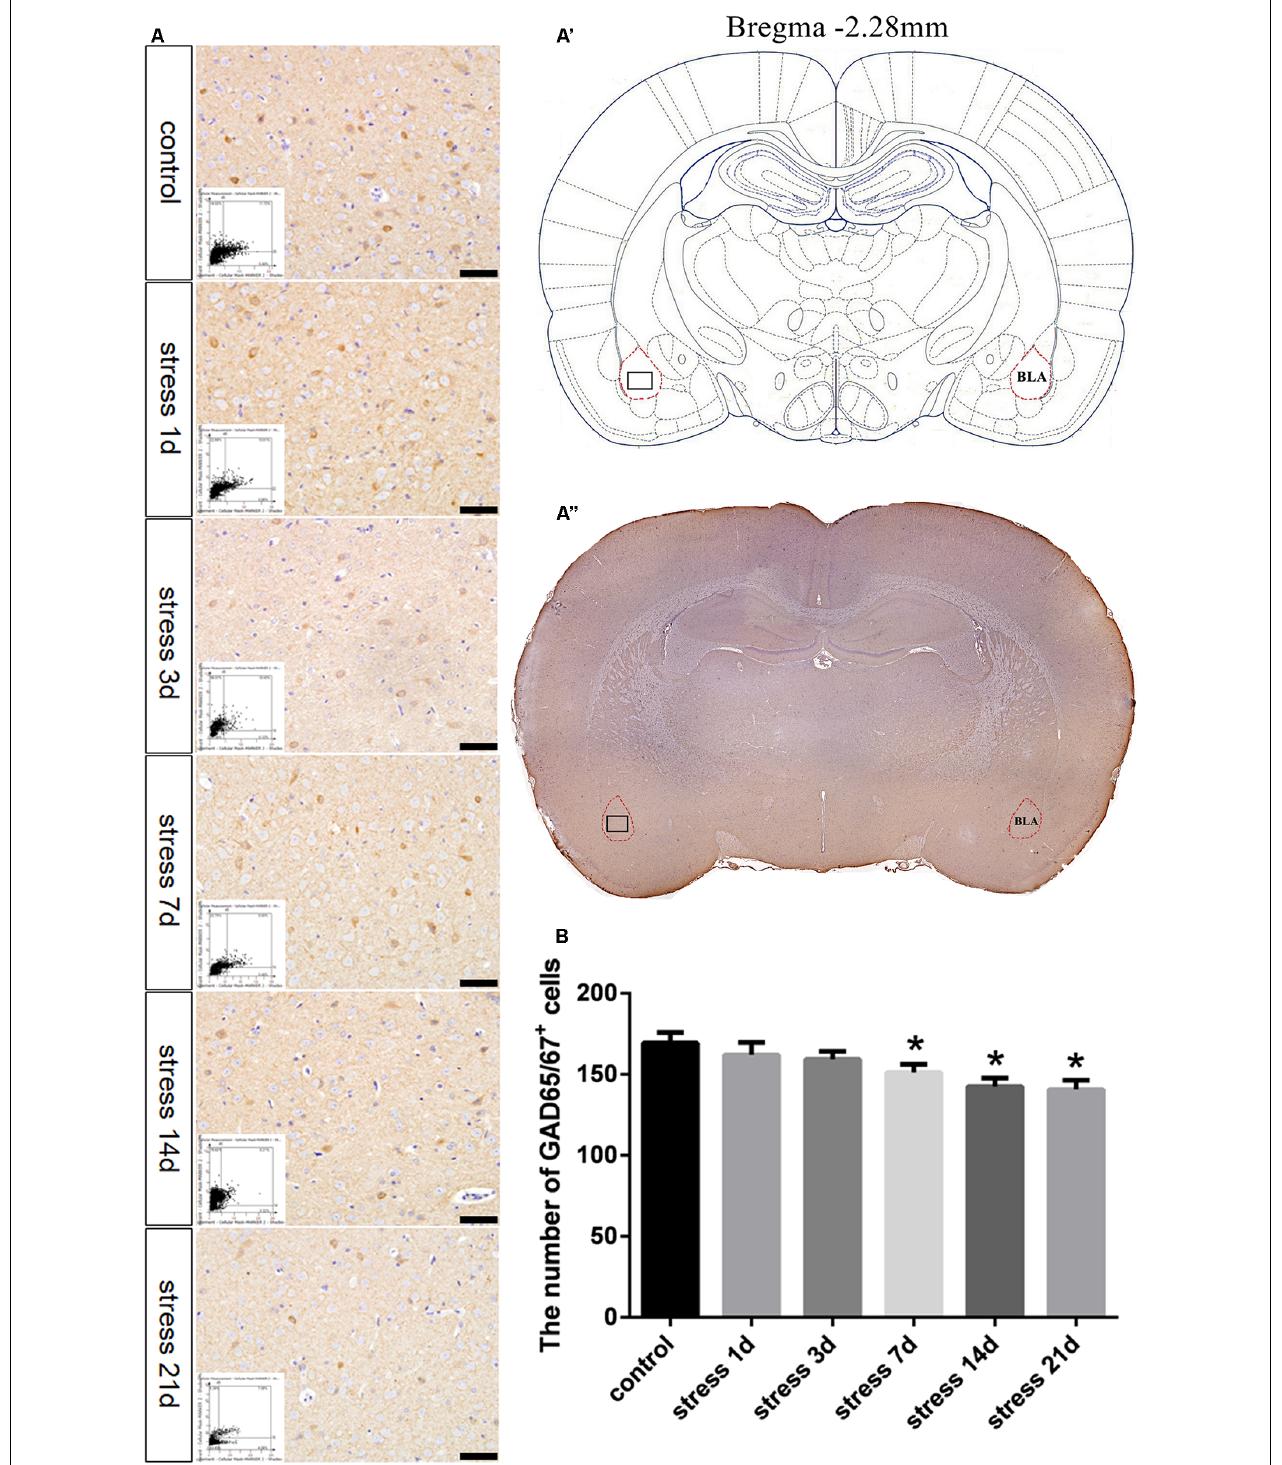
FIGURE 3 | Stress contributed to decrease in the number of GABAergic neurons. (A) Representative images showing GAD65/67 immunohistochemistry in the BLA. Images obtained by microscopy-based multicolor tissue cytometry (MMTC) are shown in the lower left corners. Bars = 50 µ m. The analyzed region within the BLA is schematically illustrated in (A (cid:48) ) (diagram modified from Paxinos and Watson, 2007) and (A”) (GAD65/67 immunohistochemistry). (B) Quantitative MMTC analysis. The data are shown as mean ± SEM, ∗ P < 0.05 vs. control group ( n = 5).